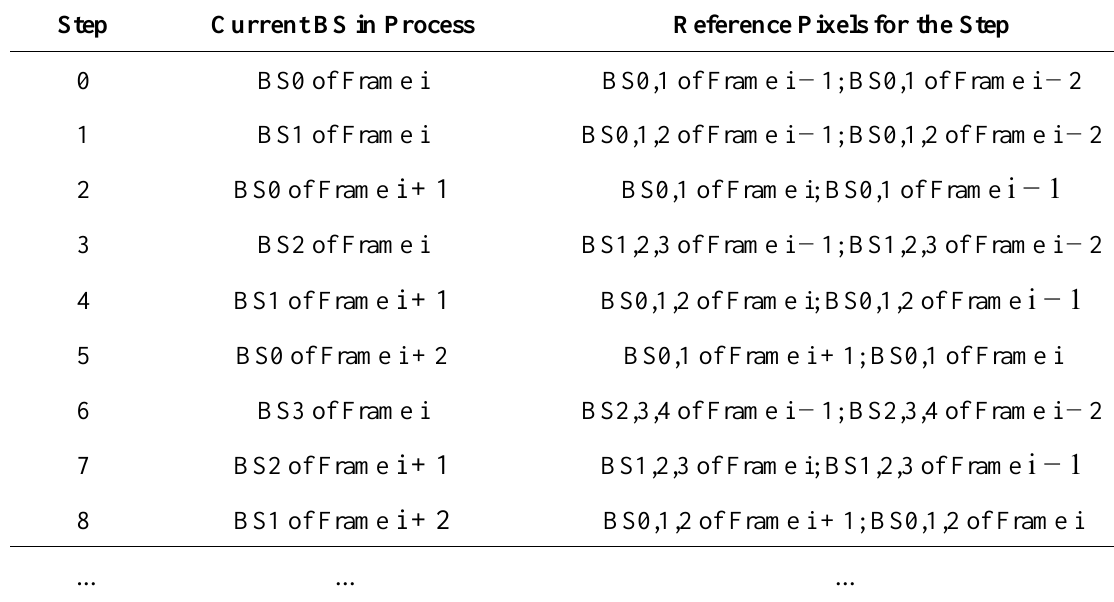
Figure 13. The order of the BSs in process for Inter-D of